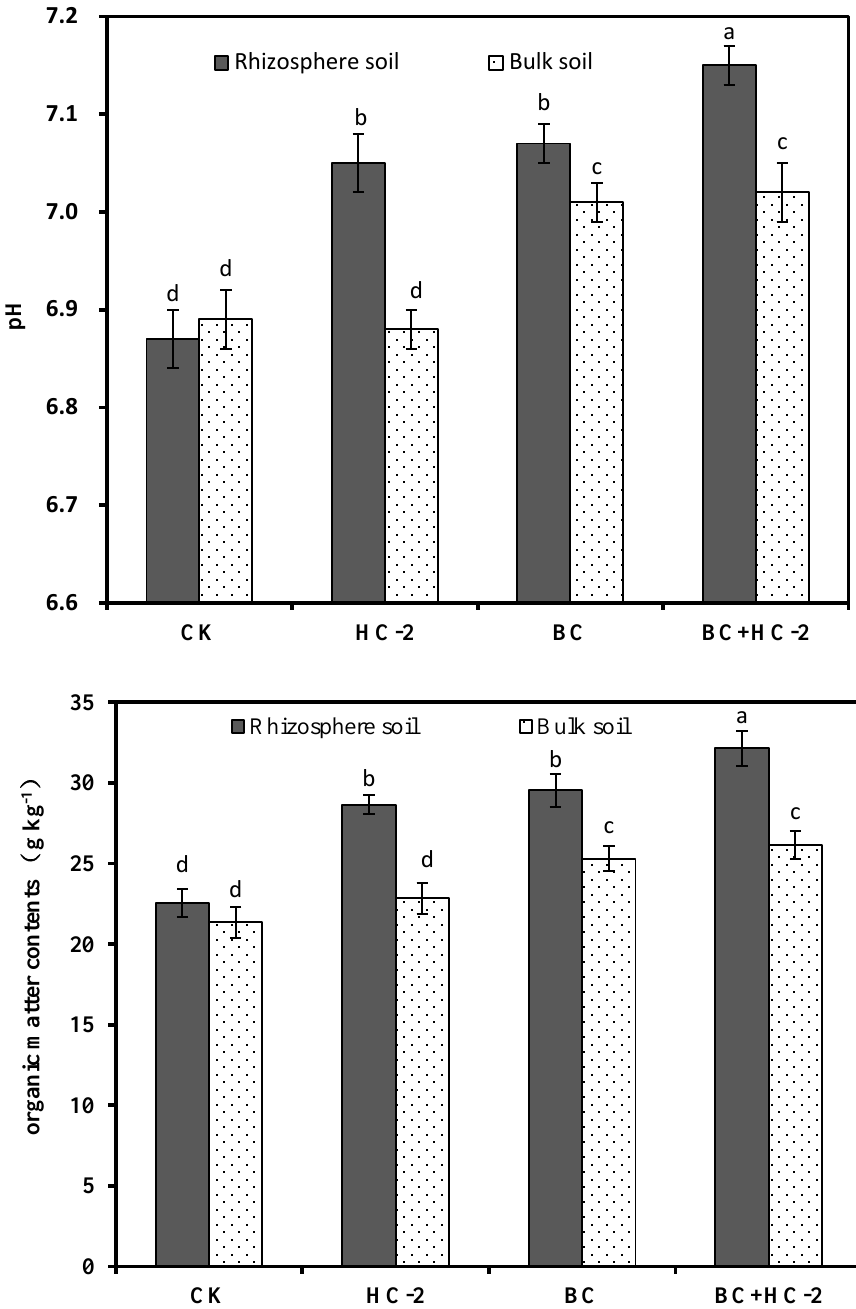
Figure 4. E ff ects of strain HC-2, BC, and BC + HC-2 on the pH and organic matter contents in the rhizosphere and bulk soils of radish. Error bars are ± standard error ( n = 3). Bars indicated by the di ff erent letter within each pH and organic matter contents were significantly ( p < 0.05) di ff erent according to Tukey’s test.